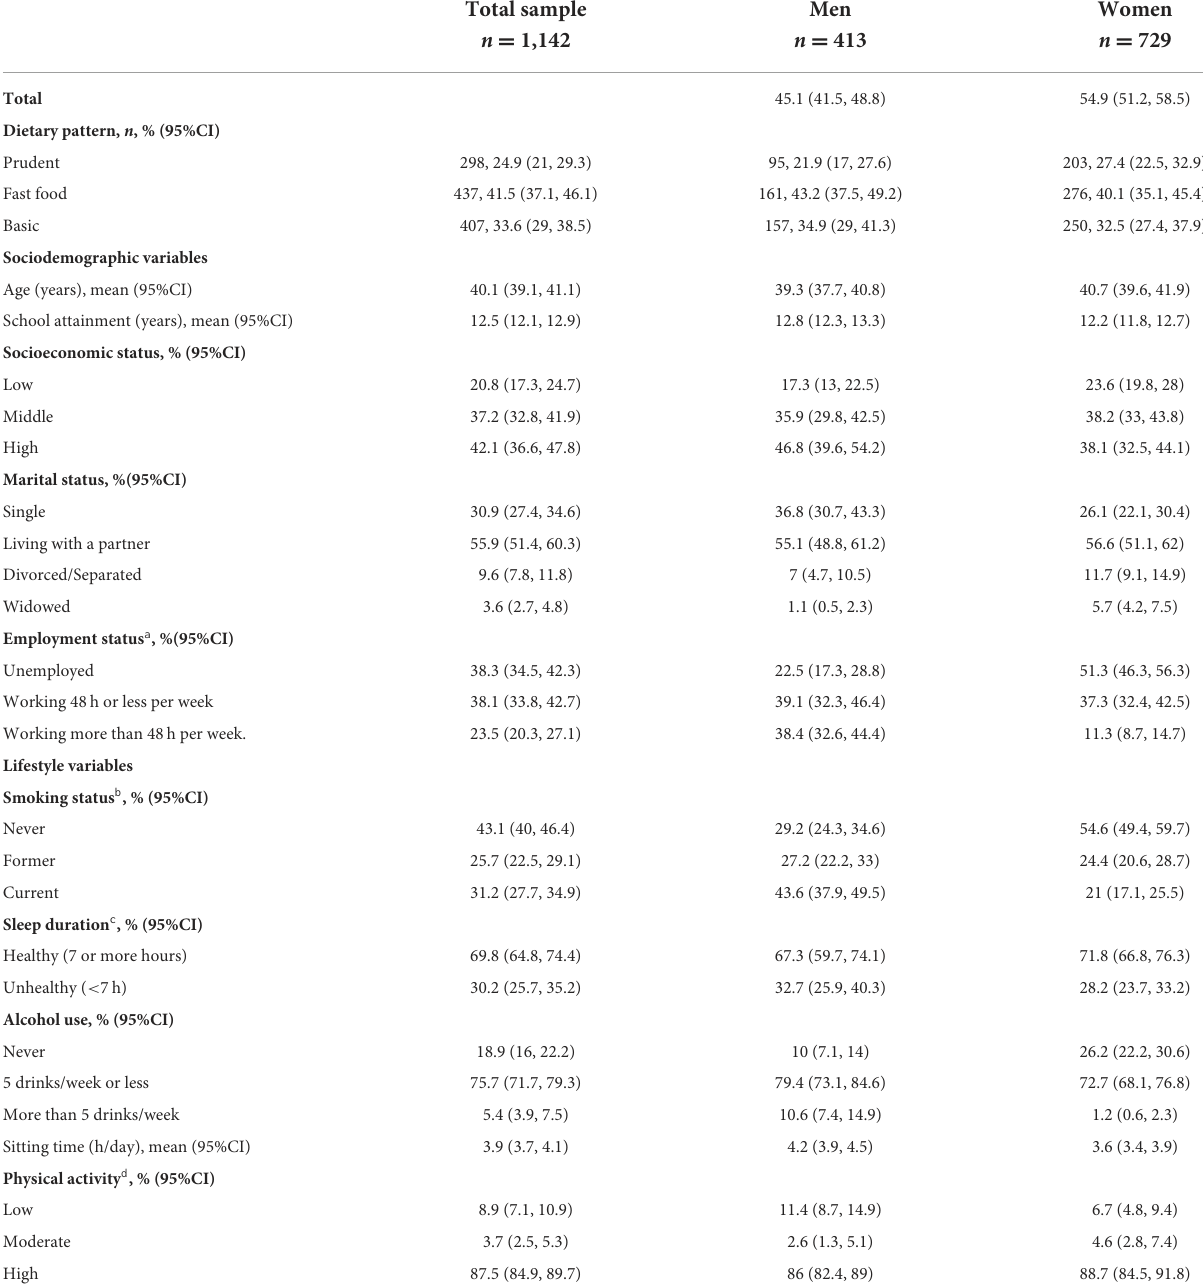
TABLE 2 Sociodemographic and lifestyle characteristics of study participants by sex in Mexico City,